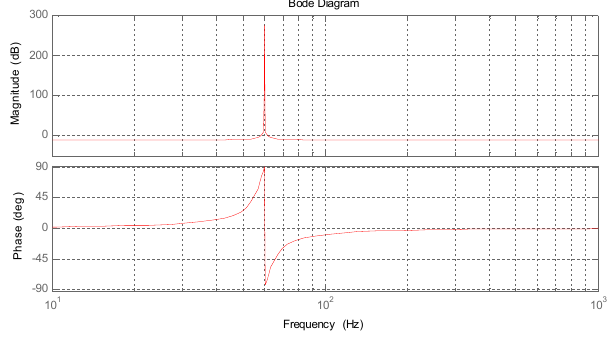
Figure 4. Bode diagram of the ideal proportional resonant (PR) controller.